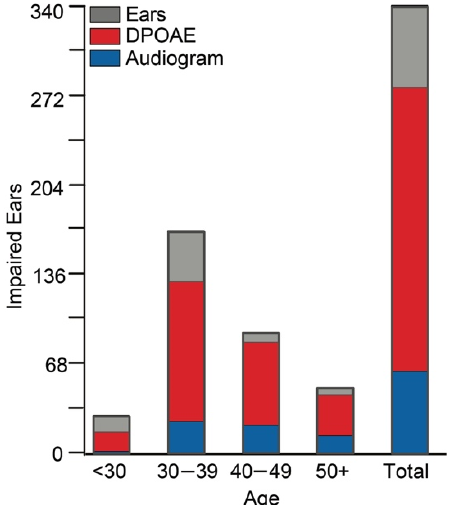
Figure 1. Total count of impaired ears identified out of 340 firefighter ears measured by standard audiogram (blue), as indicated by thresholds >25 dB HL for at least 1 frequency, as well as in DPOAE (red), as indicated by absent responses at 2 or more frequencies, plotted over the total number of ears in each age group (grey). Total impairments for all ears are also presented.